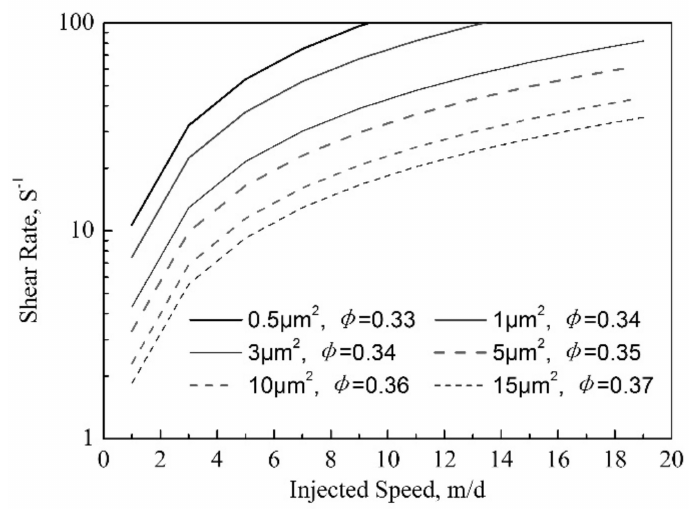
Figure 8. The relationship between injection speed and shear rate under different